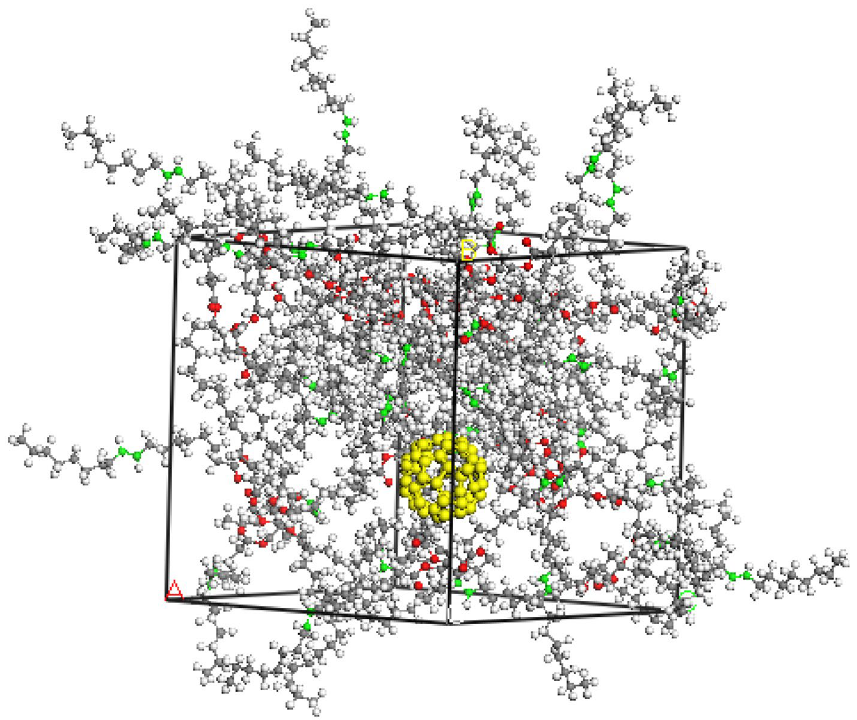
Figure 8. Cell with fullerene molecule and 20 triglyceride